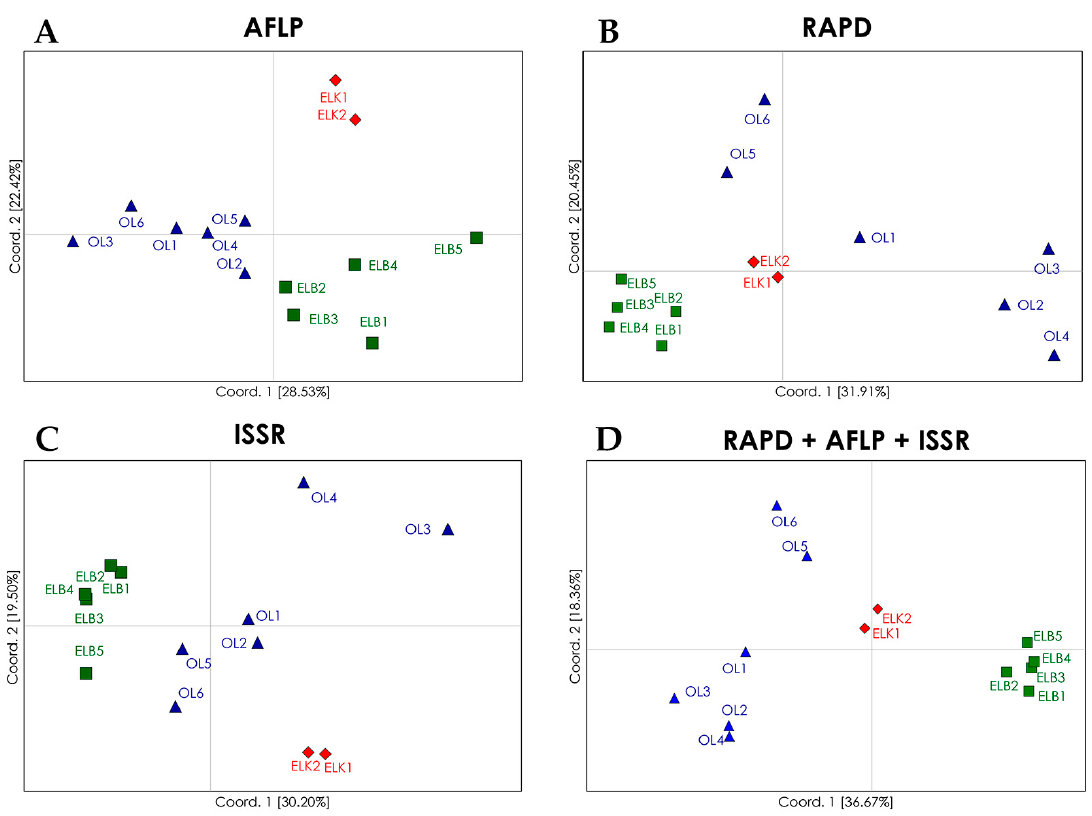
Figure 1. PCoA (principal coordinates analysis) plots of genetic differentiation ( Φ ST ) between the analyzed populations of S. purpurea determined with the use of: AFLP ( A ); RAPD ( B ); and ISSR ( C ) marker systems; and a combination of all marker systems ( D ). The analyzed locations are marked in different colors.